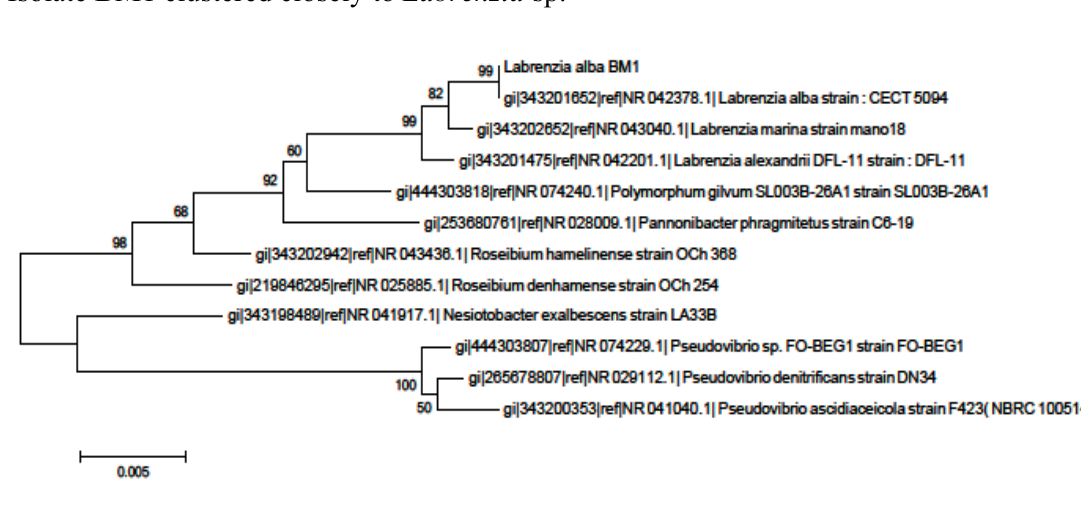
Figure 1. Phylogenetics analysis of isolate BM1. Tree was generated using MEGA 5.1. Isolate BM1 clustered closely to Labrenzia